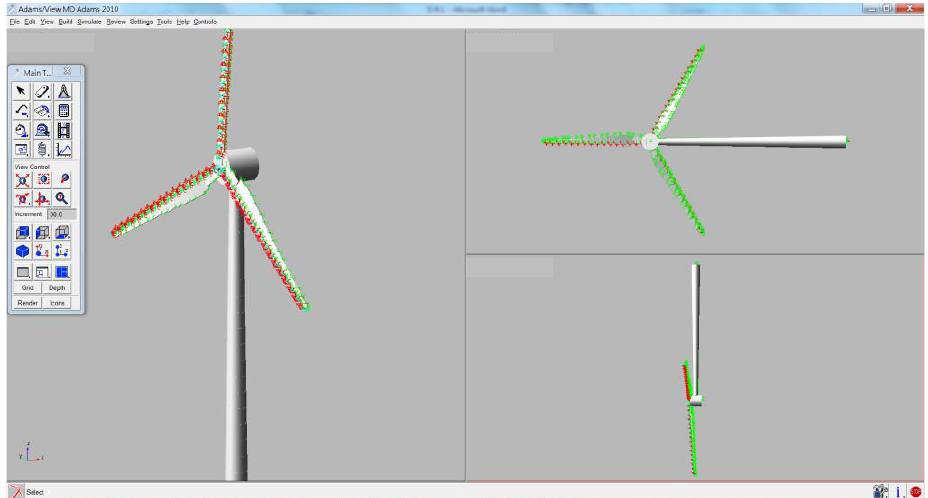
Figure 4. 3D expression of wind turbine outlook.